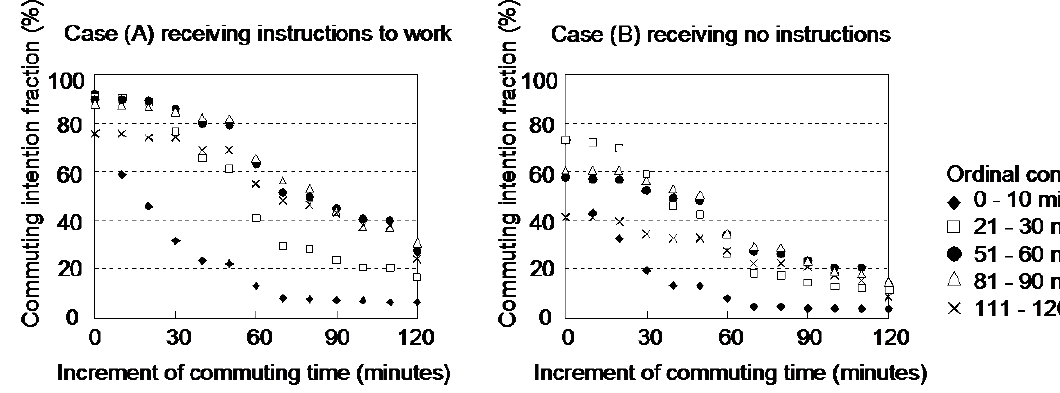
Figure 3. Ratio of commuting intention plotted against hypothetical acceptable